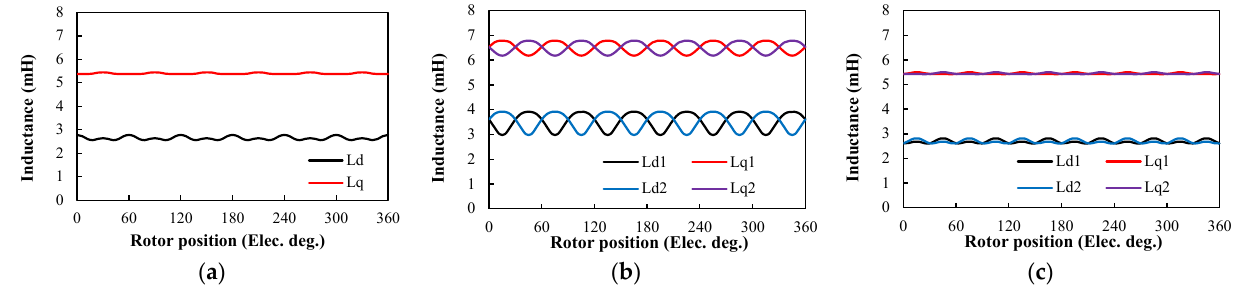
Figure 18. d- and q-axis inductances of different winding configurations at OC: ( a ) ORG; ( b ) DTP-SF; ( c ) DTP-DS.